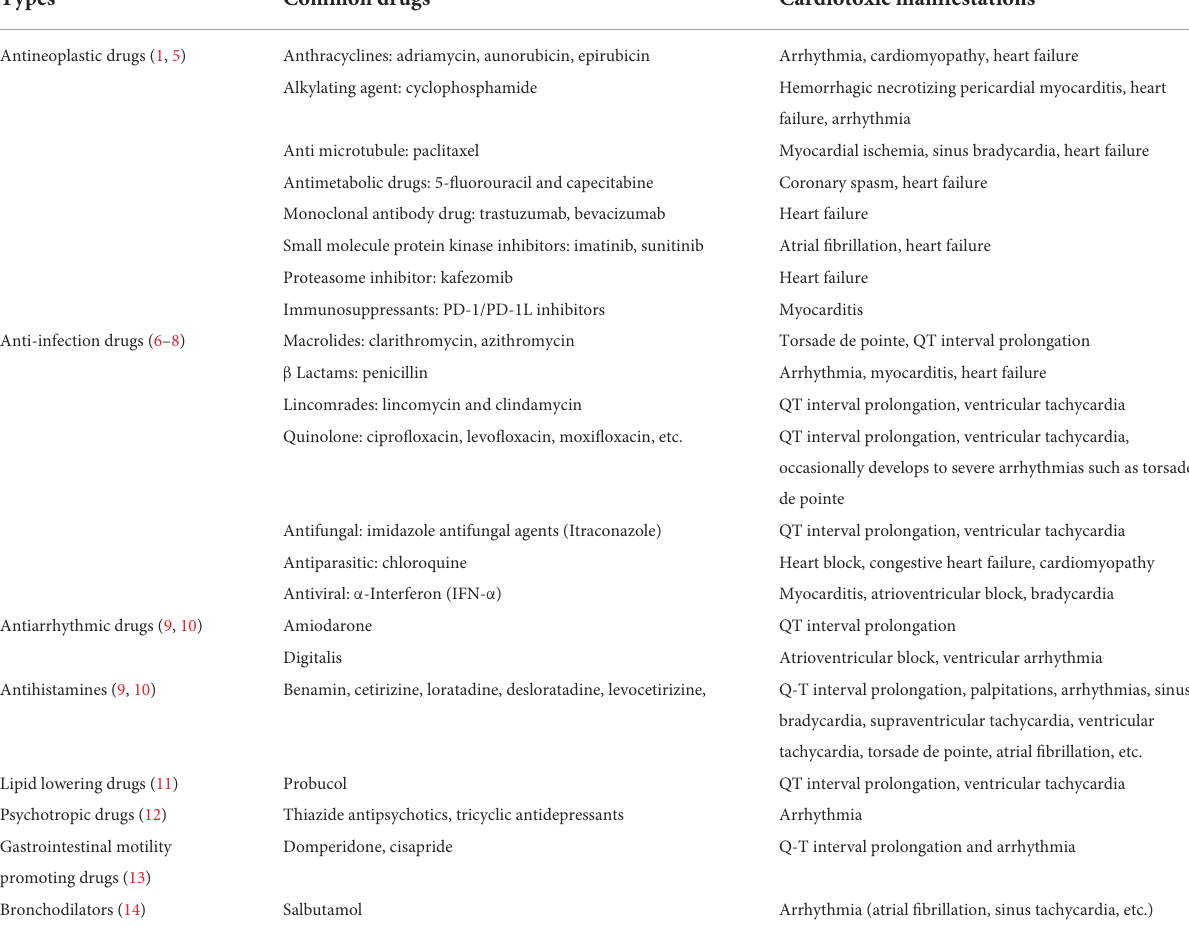
TABLE 1 Drugs that induced cardiotoxicity and the